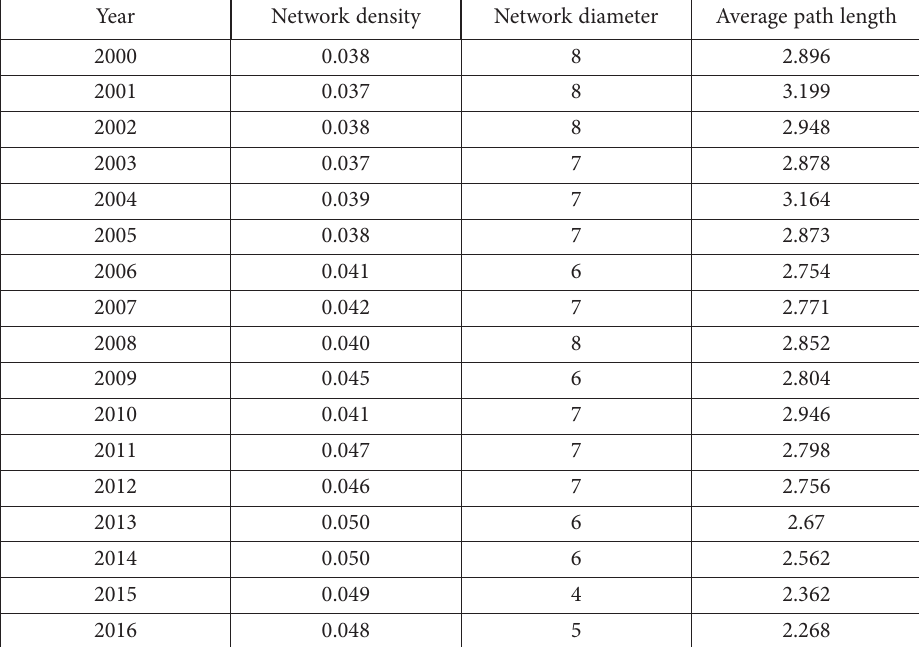
Table 2. 2000–2017 International trade indicators for potassium salt Year Network density Network diameter Average path